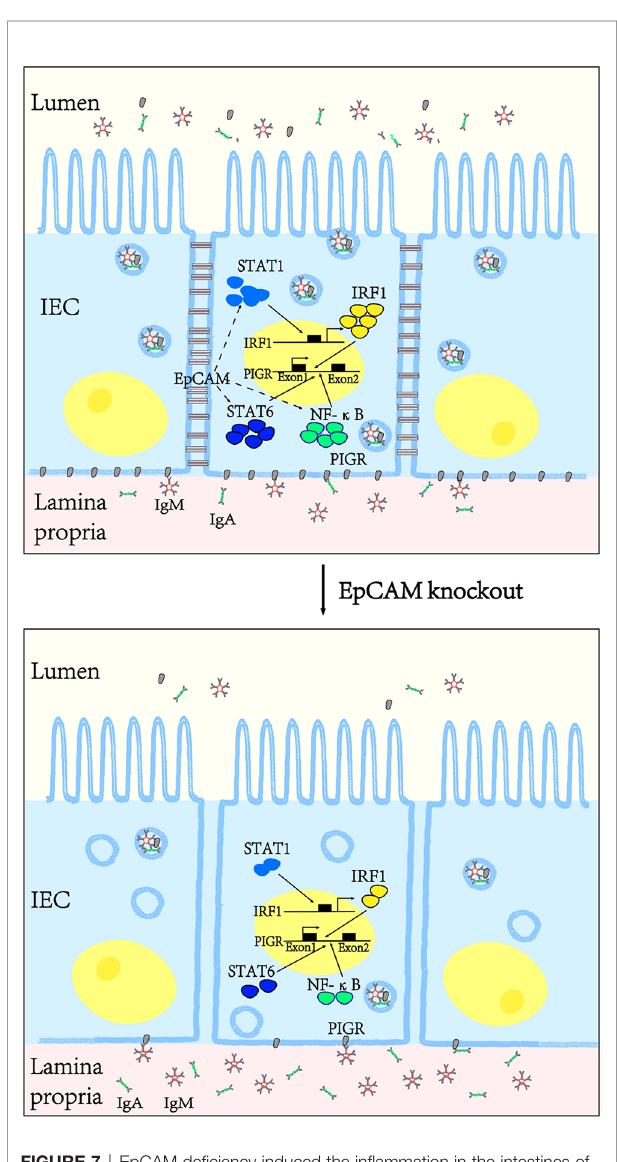
FIGURE 7 | EpCAM de fi ciency induced the in fl ammation in the intestines of mice via downregulating the expression of pIgR in the intestinal epithelial cells. EpCAM de fi ciency caused the decrease of the expression and activation of the transcriptional factors including STAT1, STAT6, NF- k B and IRF1, then caused the downregulation of the expression of pIgR in the intestinal epithelial cells, so IgA and IgM which were produced by the plasma cells under the intestinal epithelium could not be transported into the lumen of the intestines to remove pathogens there and then the in fl ammation occurred in the intestines of these